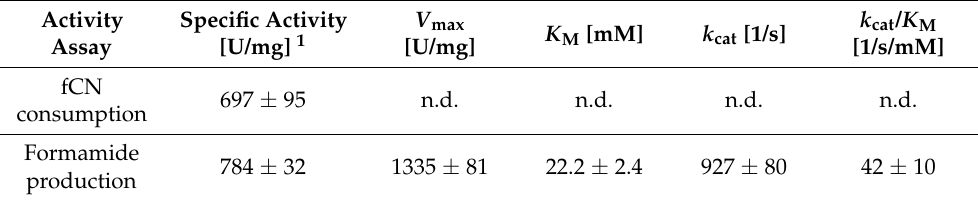
Table 1. Specific activity and kinetic parameters of enzyme NitEg.